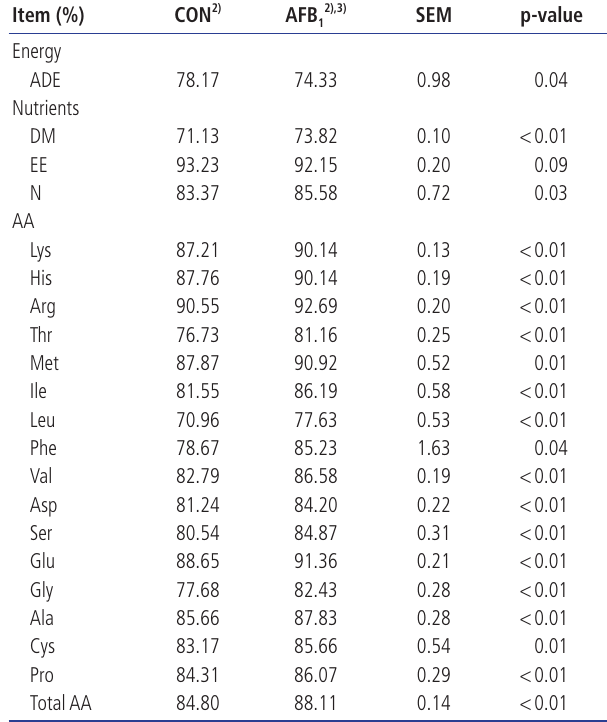
Table 6. Effects of feeding corn naturally contaminated with AFB digestible energy and nutrients digestibility in ducklings 1)